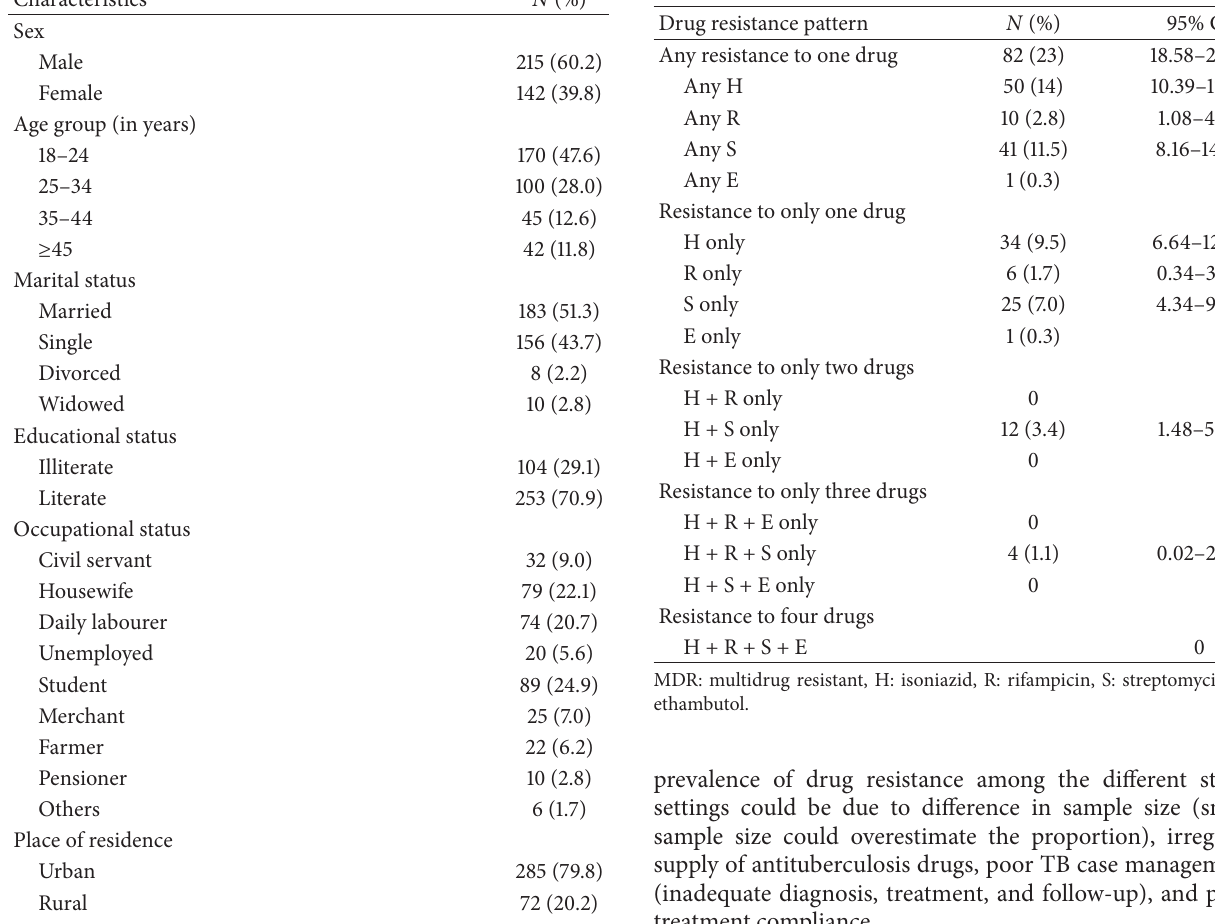
Table 2: Resistance pattern to primary anti-TB drugs among new smear positive pulmonary TB patients in eastern Ethiopia, 2013 ( 𝑛 = 357